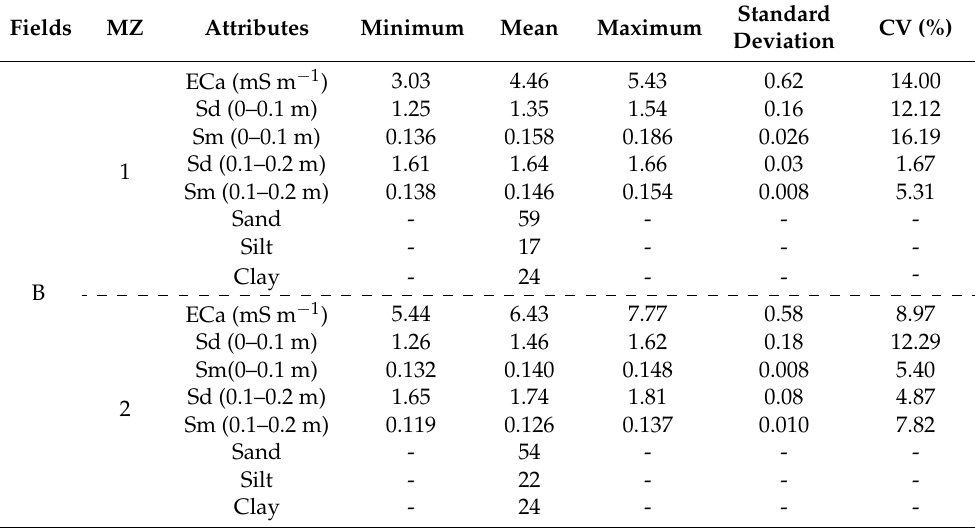
Table 2. Descriptive statistics of soil attributes: Apparent soil electrical conductivity (ECa; mS m − 1 ), soil bulk density (Sd; g cm − 3 ), gravimetric soil moisture (Sm, g g − 1 ), sand, silt, and clay content (%), for the management zones (MZs) delimited in Field B (irrigated by central pivot). Cachoeira do Sul, RS,